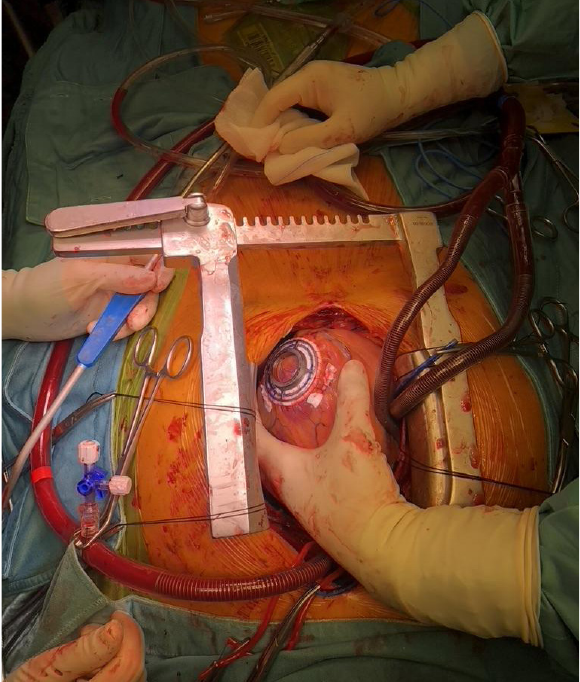
Fig. 2 - Implant of left ventricular assist device (HeartMate